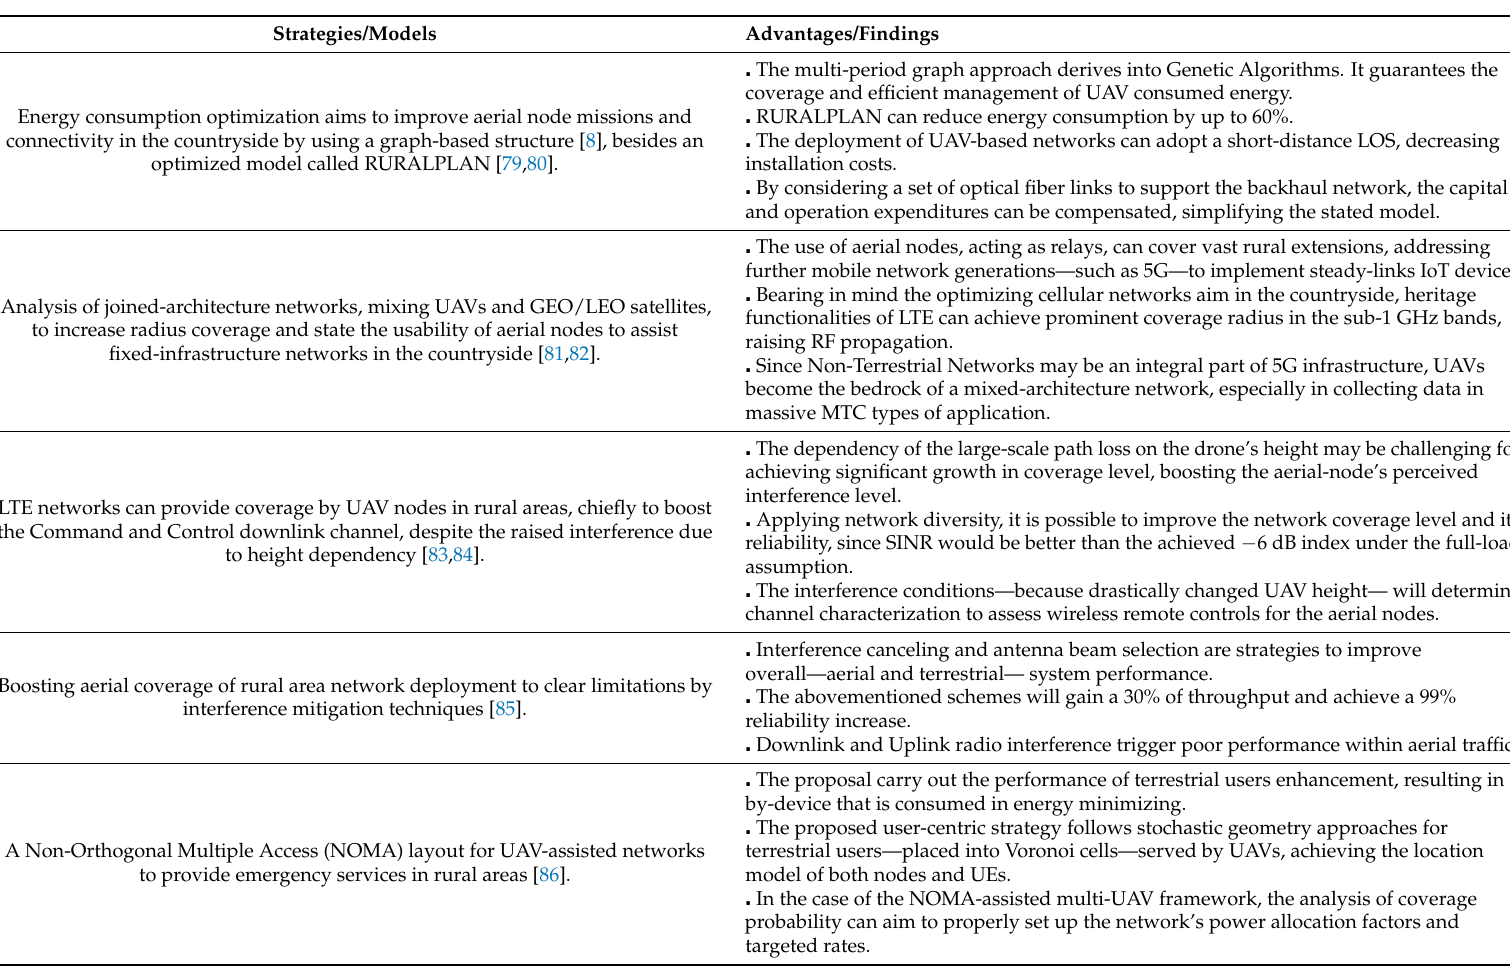
Table 5. Phases of UAV-based network models